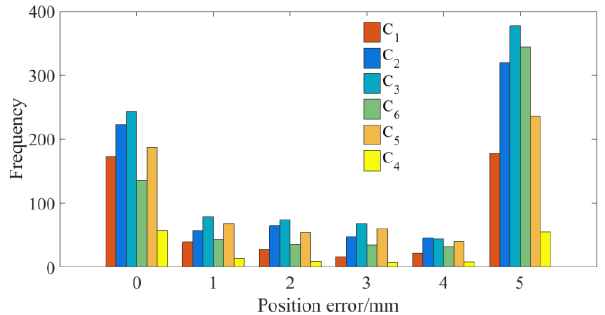
Figure 33. The UR5 robot’s position errors.